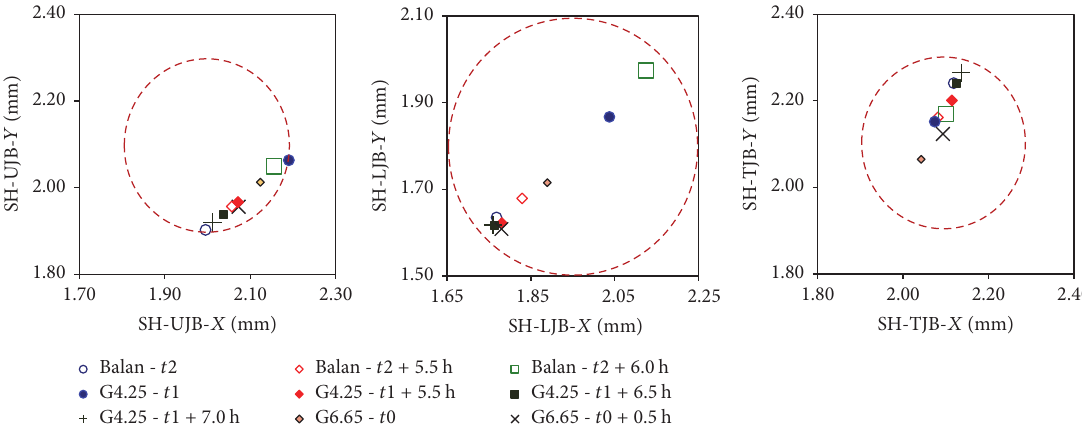
Figure 4: Shaft eccentricity in the upper, lower, and turbine journal bearings of a LHG at speed-no-load condition, with the generator rotor balanced (Balan) and unbalanced, with ISO quality grades G4.25 and G6.65.